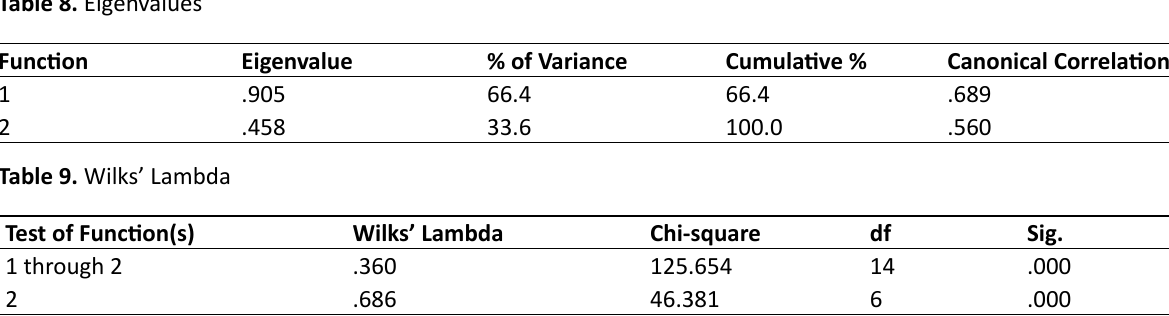
Table 8. Eigenvalues